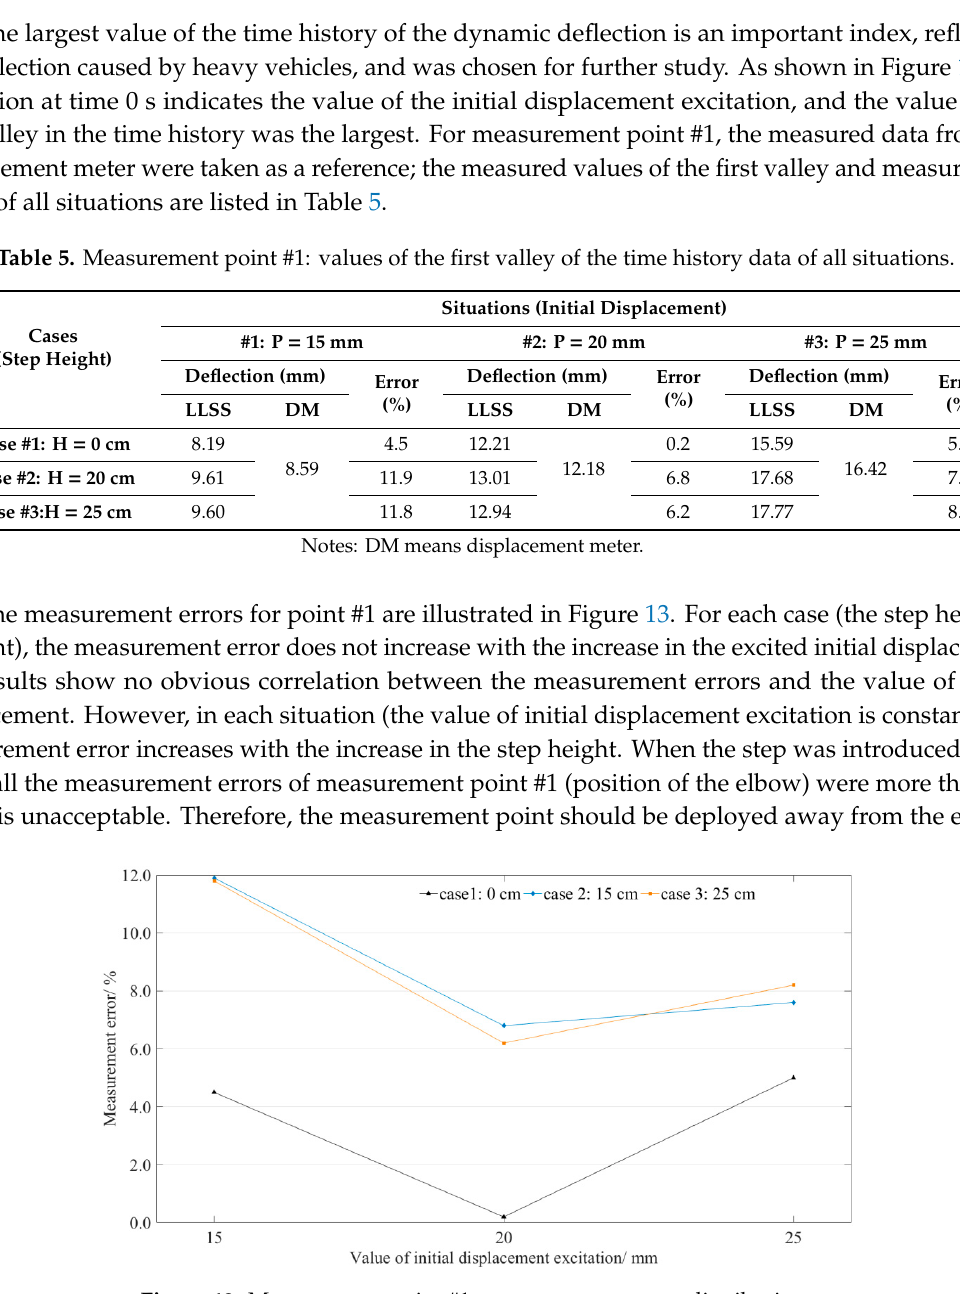
Table 5. Measurement point #1: values of the first valley of the time history data of all situations.